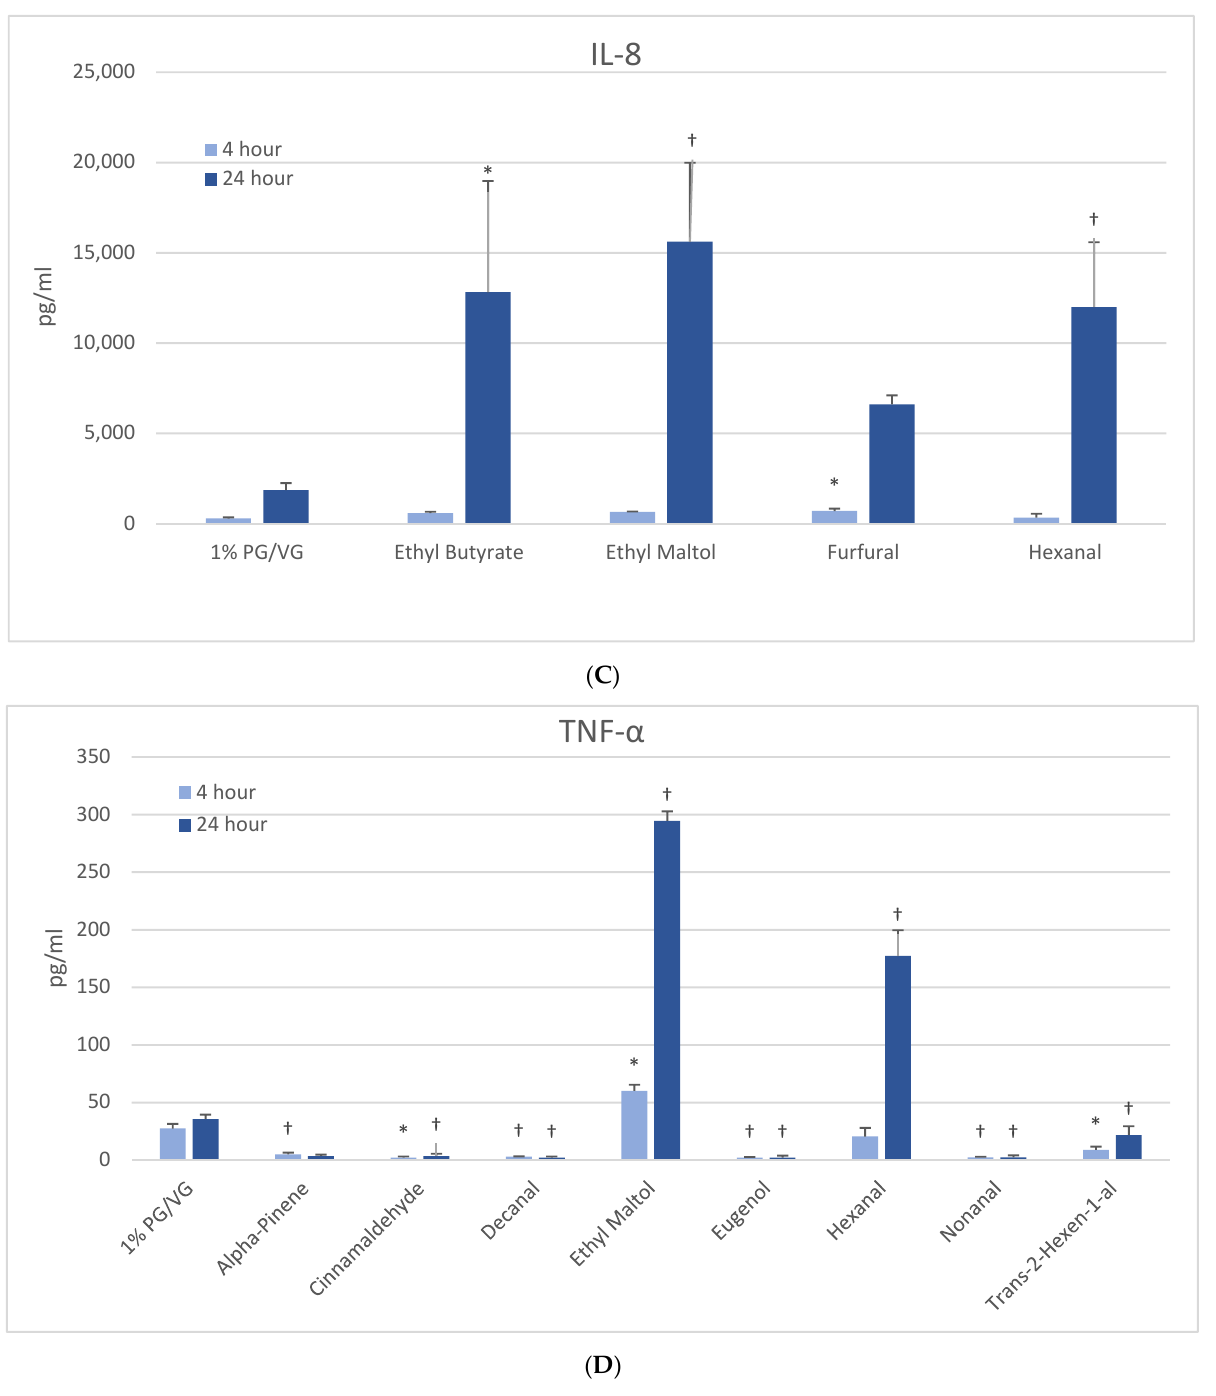
Figure 3. Cytokine production in naïve THP-1 cells measured in cell supernatants after 4 and 24 h treatment with 1000 µM of selected flavoring chemicals. ( A ) IL-1 β ; ( B ) IL-6; ( C ) IL-8; ( D ) TNF- α . Data are presented as means ± standard error. Significance: * p < 0.05 as compared with vehicle control (1%PG/VG) and † p < 0.05 with reduced viability (Figure1). * p < 0.05, † p < 0.05 with reduced viability (Figure1).